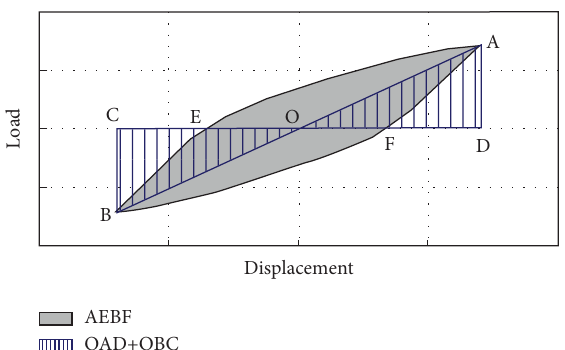
Figure 14: Definition of energy dissipation and equivalent viscous damping ratio